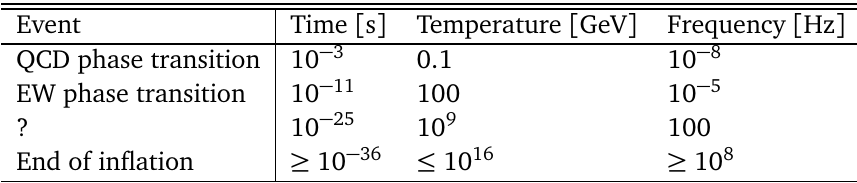
Table 4: Overview about the minimal frequencies of gravitational waves from differ- ent potential sources in the early